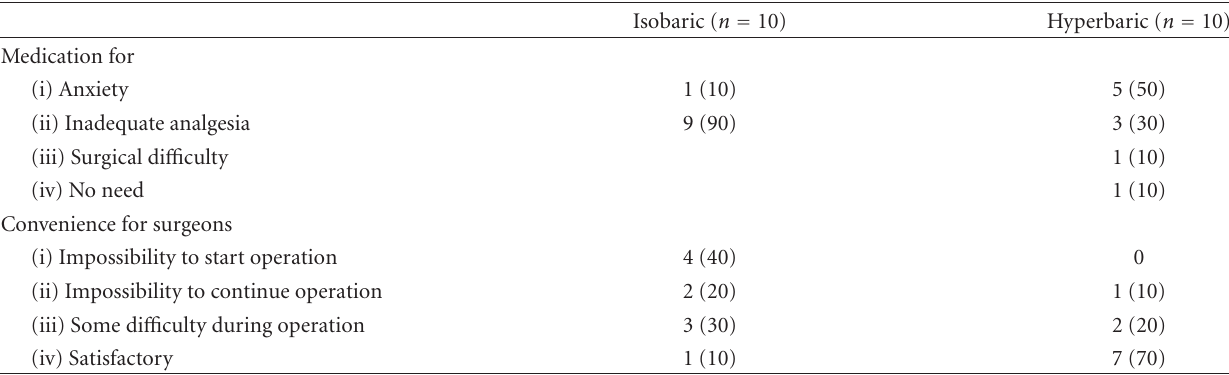
Table 3: Reasons for supplemental drugs and convenience in performing gynecological surgery with abdominal incision in patients receiving intrathecal blocks with isobaric or hyperbaric levobupivacaine. Values are number (proportion). Isobaric ( n = 10) Hyperbaric ( n =